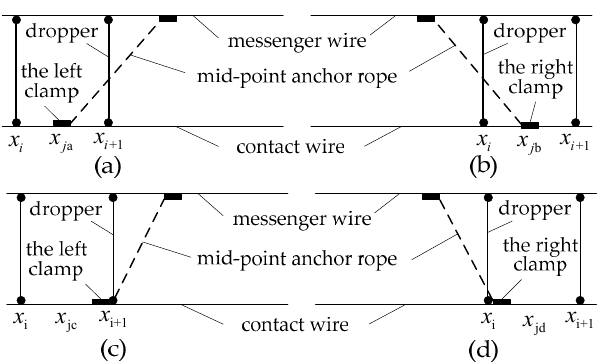
Figure 6. Correction diagram of the position of the mid-point anchor clip. (Subgraphs ( a – d ) represent four different relationships between the theoretical position of the dropper and the mid-point anchor clip within the span, respectively.)